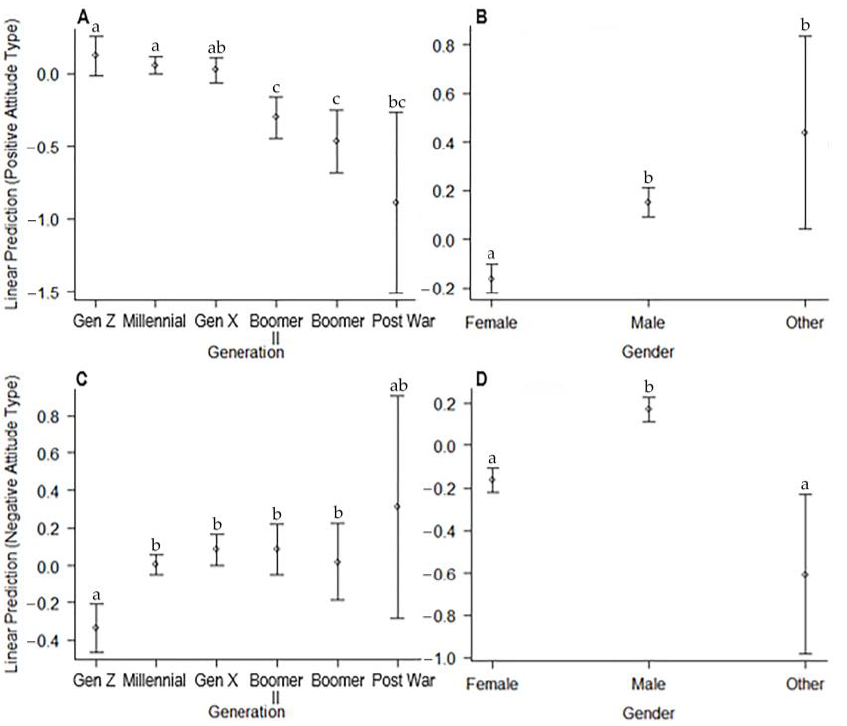
Figure 3. Predictor effect plots for regression models for the python experiment, showing the effect of ( A ) generation and ( B ) gender on positive attitudes, and the effect of ( C ) generation and ( D ) gender on negative attitudes. In each panel, results are averaged over levels of other predictor variables. Linear predictions are shown with 95% confidence intervals as error bars. Predictor levels that do not share any letter are significantly different ( p < 0.05) as determined by pairwise comparisons conducted using the Tukey